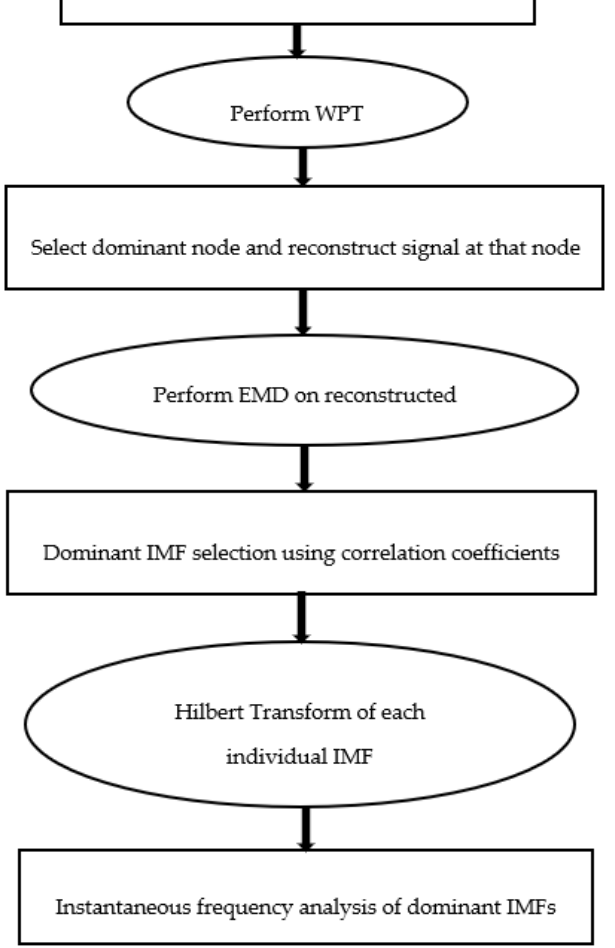
Figure 5. Operation procedures of proposed Hilbert–Huang Transform